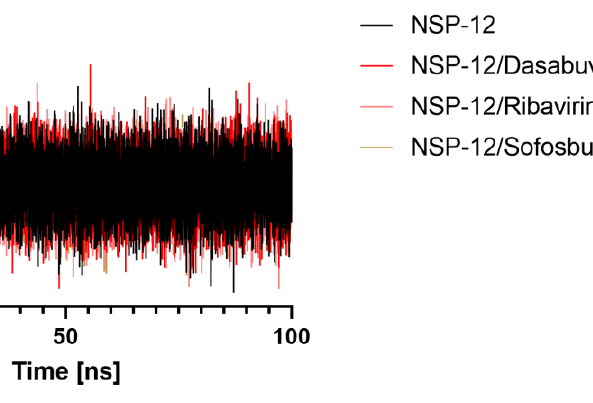
Figure 9. The system’s temperature during 100 ns of MD simulation. Figure 9. T he system’s temperature during 100 ns of MD simulation. Figure 9. T he system’s temperature during 100 ns of MD simulation.